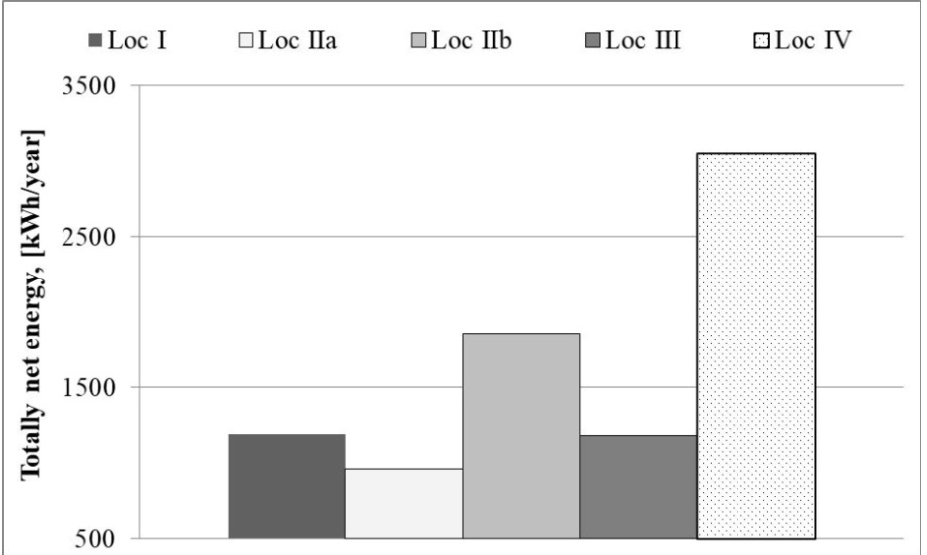
Figure 13. Amount of energy supplied to the power grid by the wind turbine WT1.